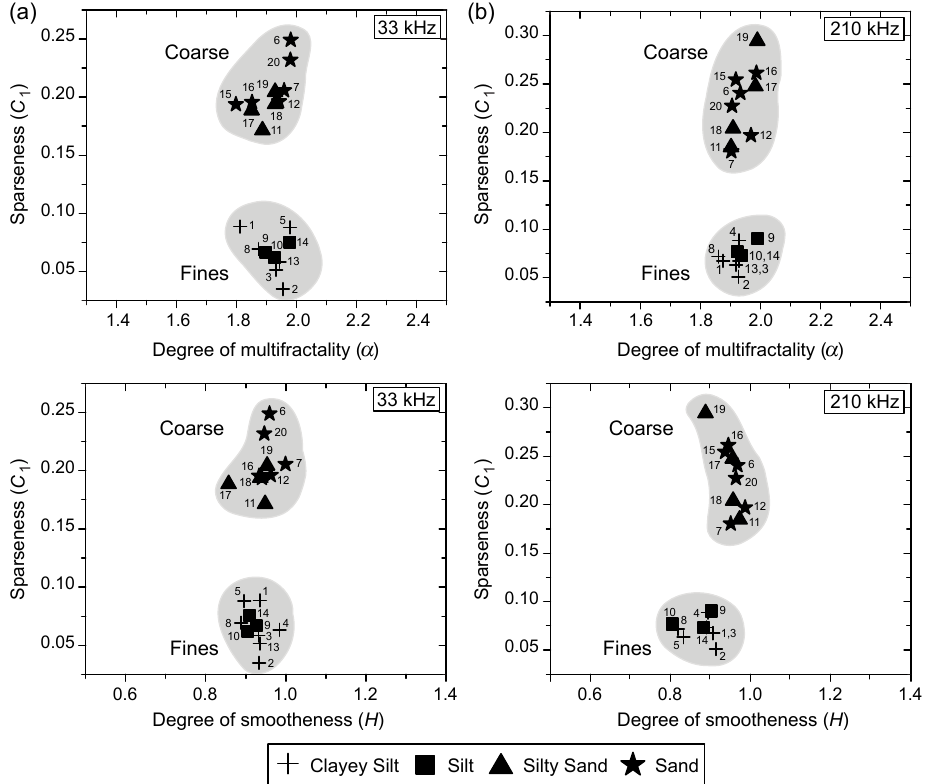
Fig. 6. A quantitative comparison between the scale invariant multifractal parameters ( α , C 1 , and H) at 33 and 210kHz. The shaded region represents the coarse and fine sediment